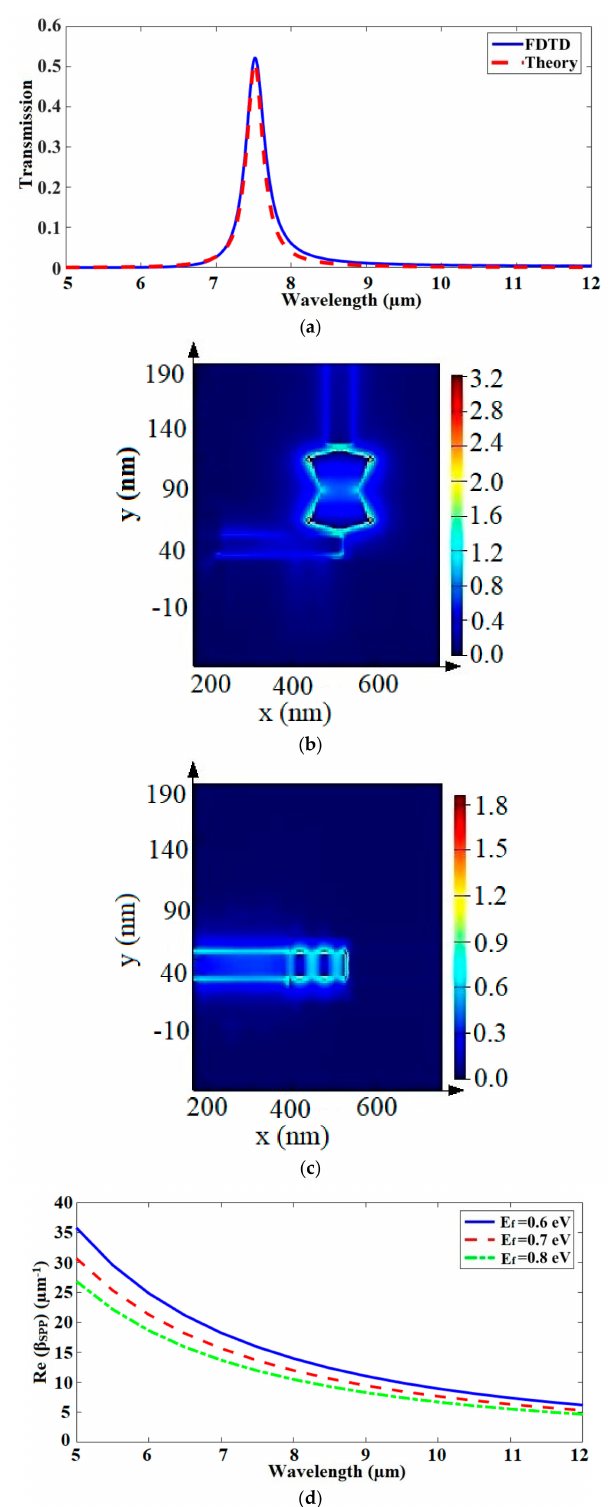
Figure 2. ( a ) Transmission spectrum of the resonator structure of Figure 1 obtained by numerical FDTD and theoretical CMT methods. | E | Field profiles of the resonator structure of Figure 1 for ( b ) the resonance wavelength of λ = 7.5 µ m, ( c ) the non-resonance wavelength of λ = 6.5 µ m, and ( d ) the dependence of the real part of the β SPP (Equation (4)) of the graphene layer for di ff erent Fermi energies of